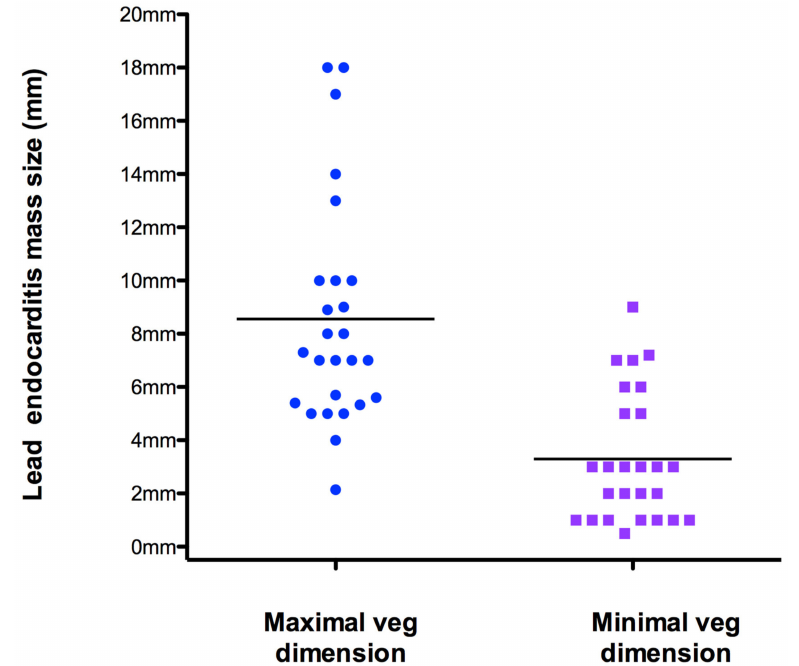
Figure 1. Individual value bar-graph depicting longer and shorter dimensions of lead vegetations. The two lines in the graph indicate the mean values. Veg = vegetation.